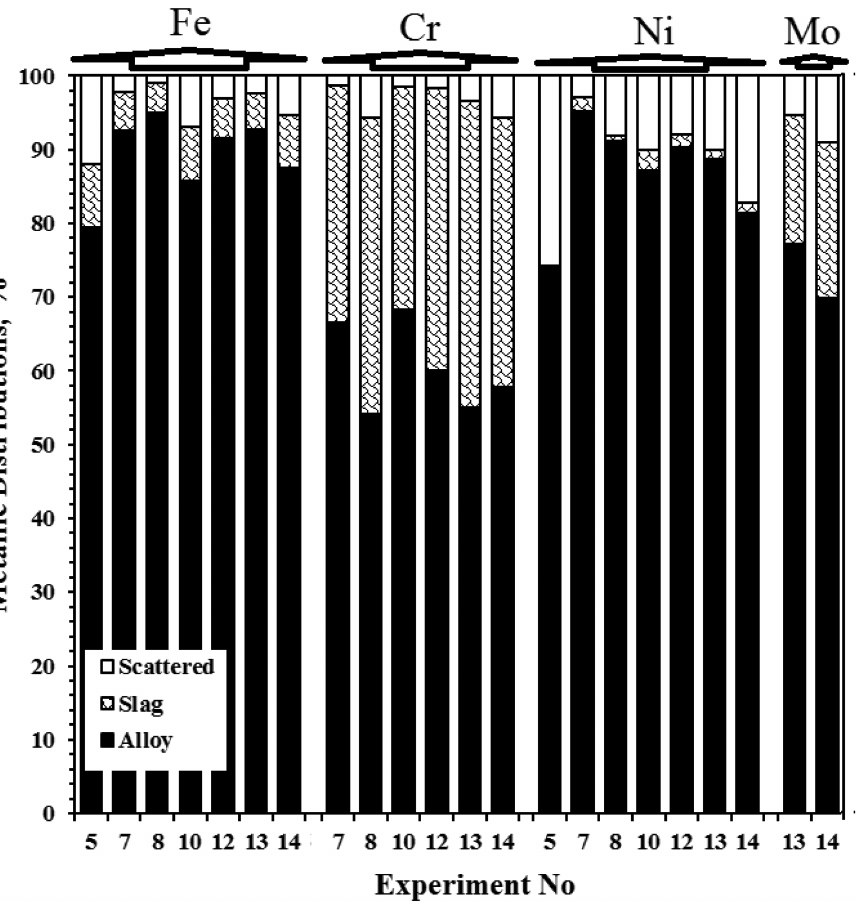
Figure 6: Metal distributions in alloy, slag and scattered parts (Experiment numbers and corresponding experimental conditions are given in Table 5 in detail.).